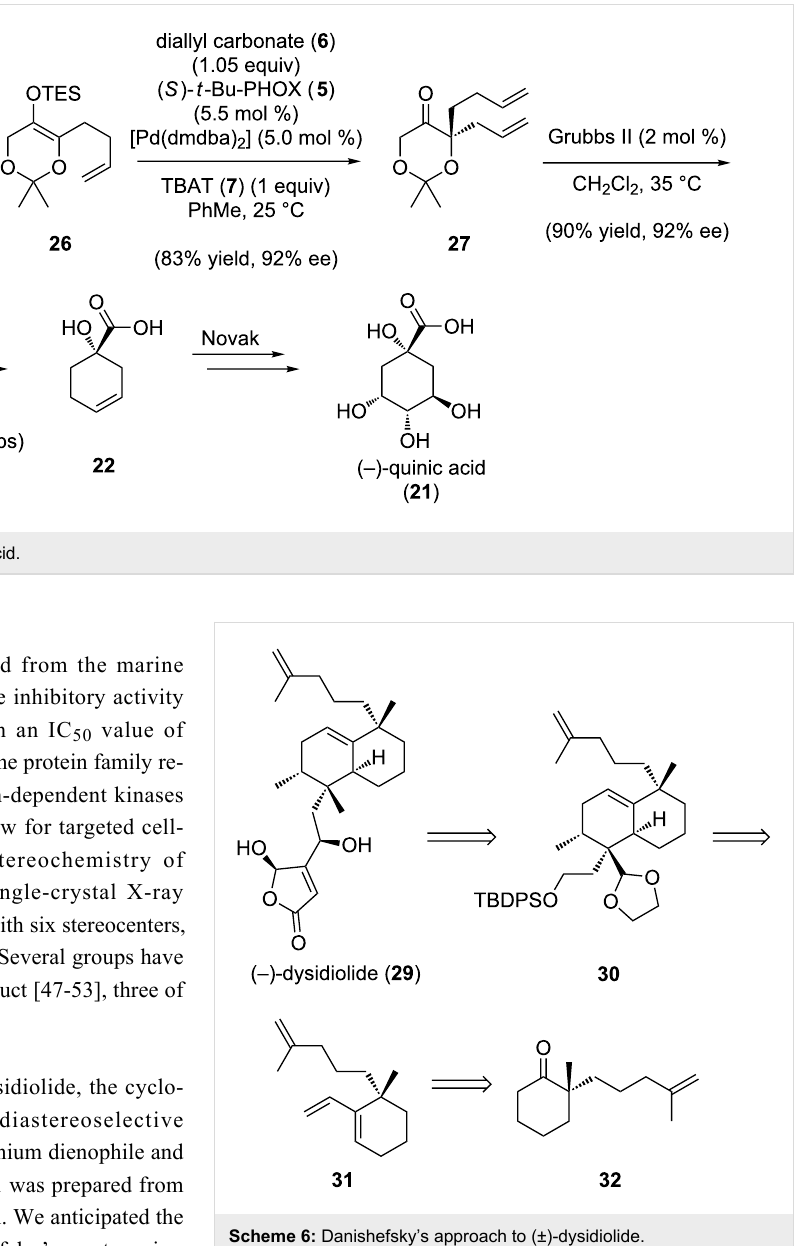
Scheme 6: Danishefsky’s approach to